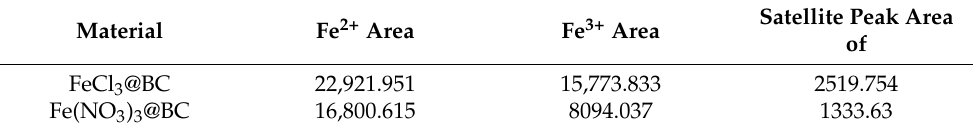
Table 2. Peak area of Fe 2+ and Fe 3+ in FeCl 3 @BC and Fe(NO 3 ) 3 @BC.